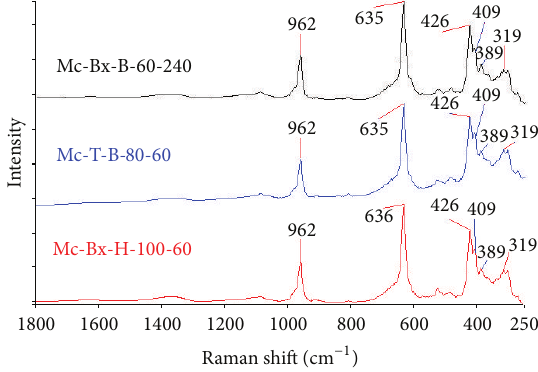
Table 2: Crystallographic data of synthesized magnesium borates.